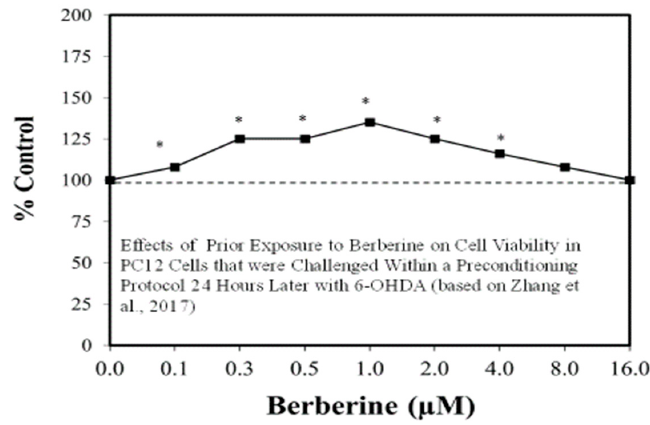
Figure 7. Effects of prior exposure to berberine on cell viability in PC12 cells that were challenged within a preconditioning protocol 24 h later 6-hydroxydopamine (6-OHDA) (Source: Zhang et al. [69]).